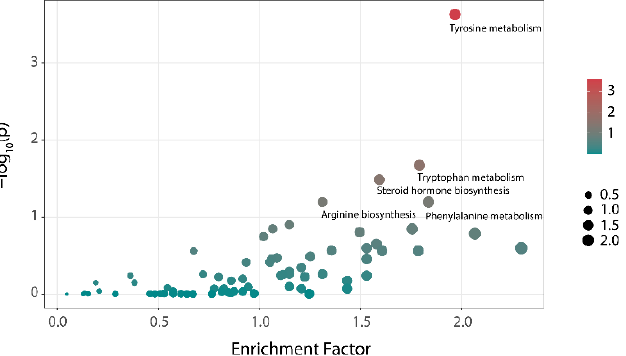
Figure 5. Analysis of the differences in metabolic pathways between the NC group and HC group (bubble color represents the hypergeometric test p -value of the metabolic pathway. Bubble size indicates the number of differential metabolites involved in this pathway).